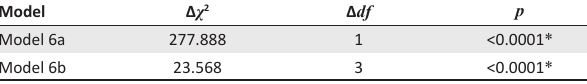
TABLE 4: Difference testing for competing structural